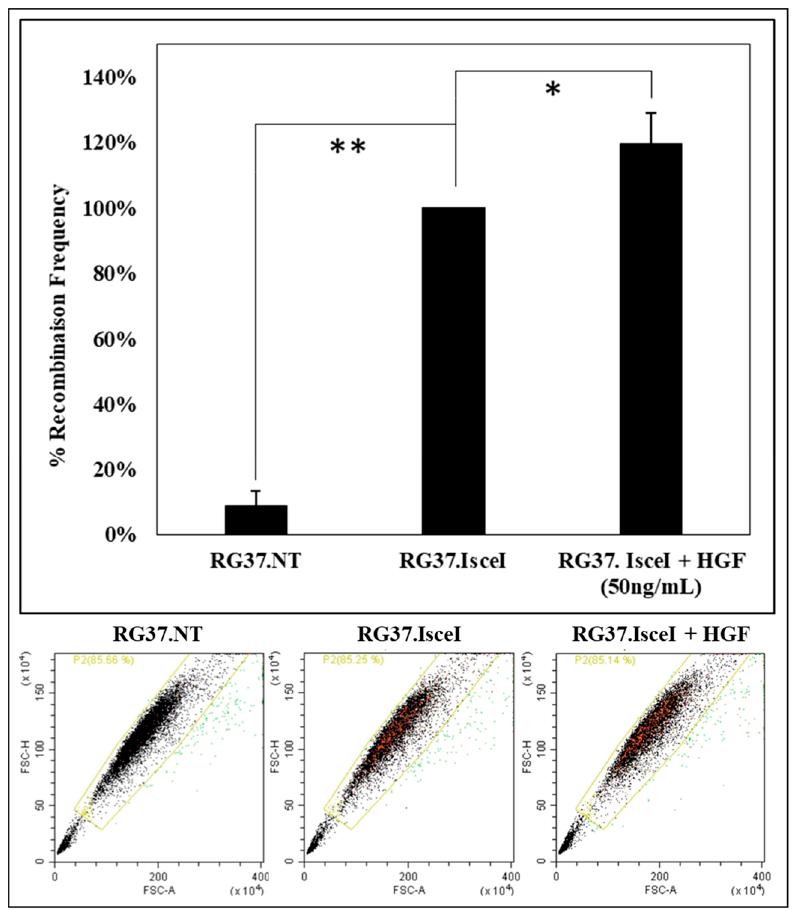
Figure 9. Activation of c-MET by HGF increases the repair of double-strand breaks by homologous recombination. Frequency of HR in DR-GFP RG37 cells pre-treated or not with HGF (50ng/mL for 24h) is estimated by DR-GFP assay. The data represent the mean of the percentage recombination frequency of three independent experiments ( n = 3; error bars: s.d; * p < 0.05; ** p < 0.01). Representative diagrams of RG37 expressing reconstituted GFP protein (population in green) and cells negative for GFP (main population).